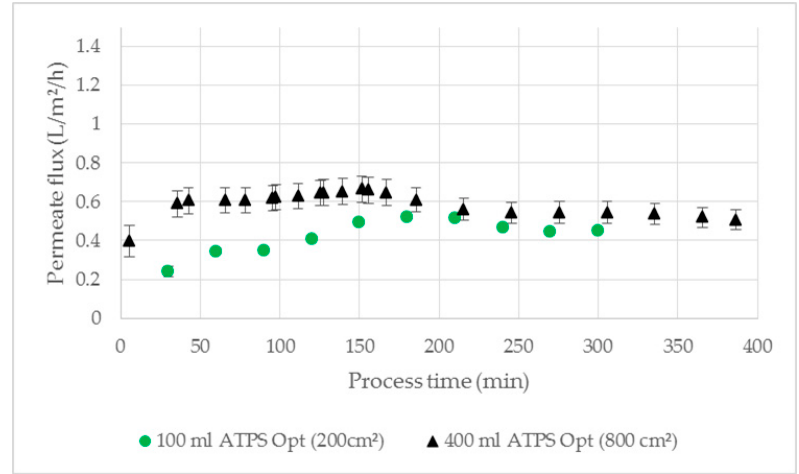
Figure 12. Permeate flux comparison between 200 cm 2 (V = 100 mL) and 800 cm 2 (V = 400 mL) membrane area for membrane based phase separation of ATPS Opt with cultivation broth as feed. TMP = 100 mbar, dP = 250 mbar, Q = 16.7 mL/min.